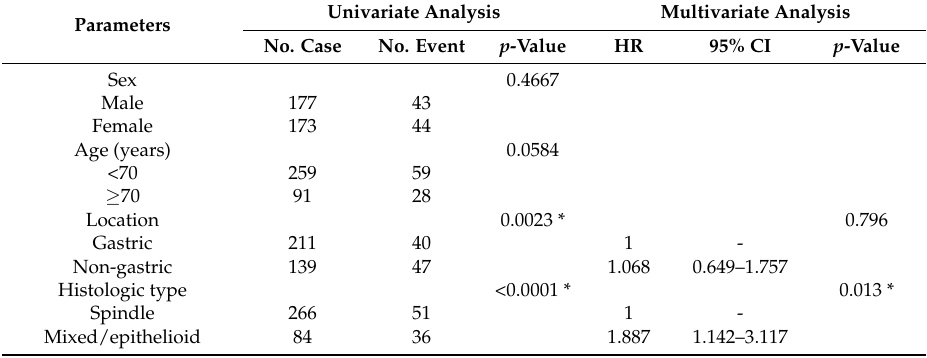
Table 2. Univariate and multivariate analyses for disease-free survival according to gene and